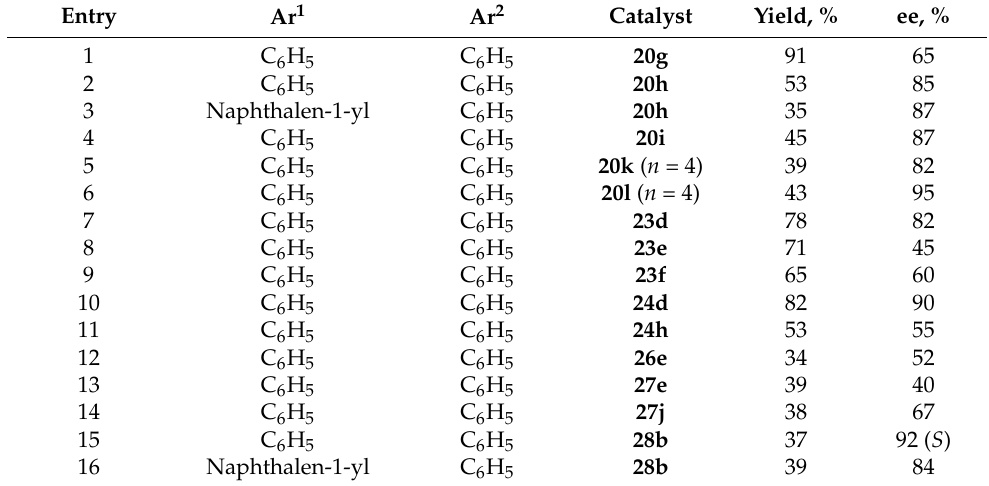
Table 1. Effect of crown ethers in the Michael addition of 2-nitropropane ( 50 ) to chalcones ( 49 ). Entry